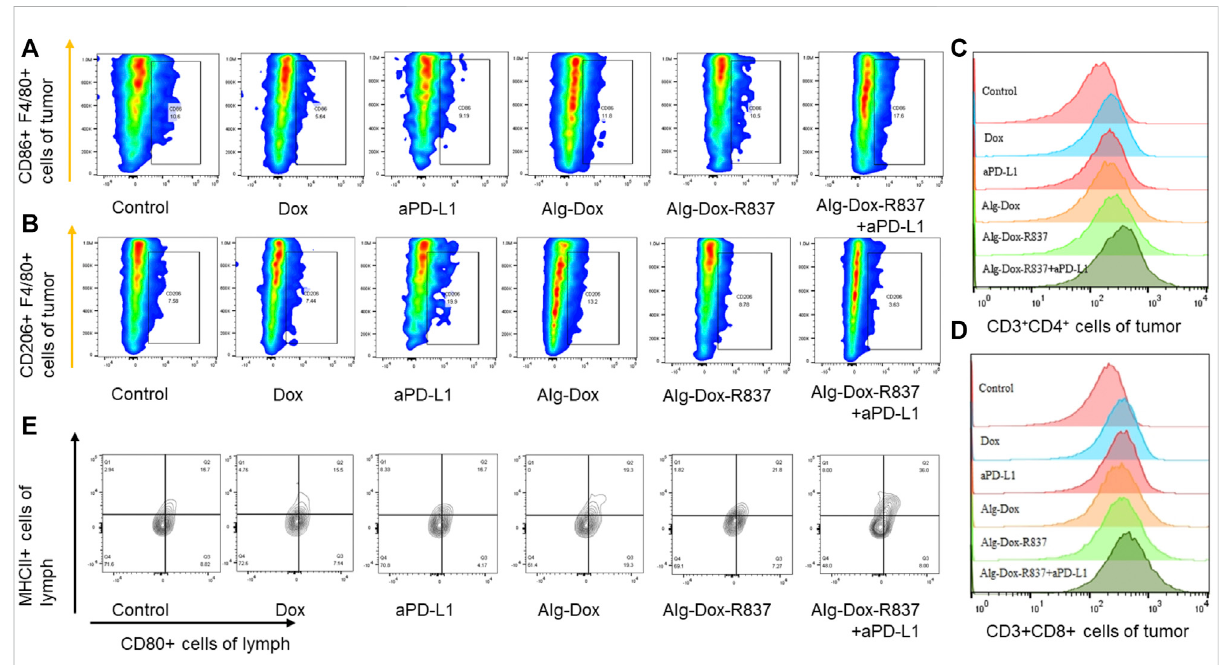
FIGURE 6 Remodeling of the tumor microenvironment (A) Changes in the number of M1-type macrophages (F4/80 + CD86 + ); (B) Changes in the number of M2-type macrophages (F4/80 + CD206 + ); (C) Changes in the number of helper T cells (CD3 + CD4 + ) after treatment; (D) Changes in the number of killer T cells (CD3 + CD8 + ) after treatment; (E) After treatment, the activation of DC cells in lymph nodes.